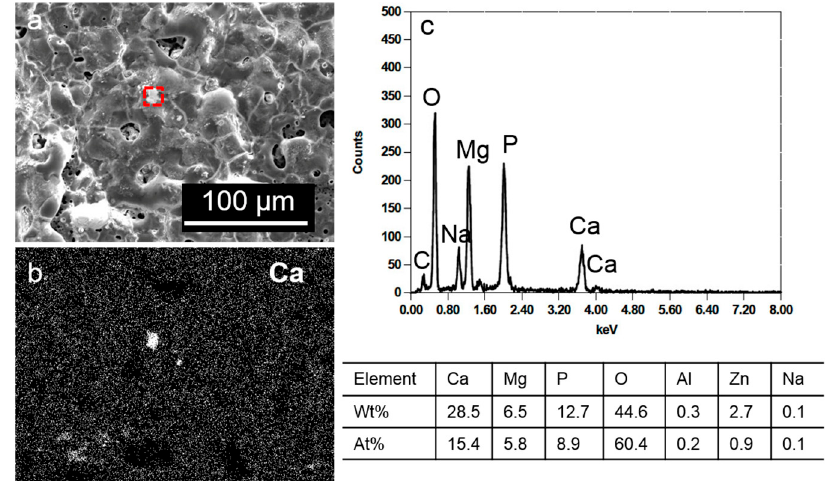
Figure 8. ( a ) SEM micrograph of the PEO film resulting from 10 min anodization of AM60-1Ca specimen in 0.5 mol dm − 3 Na 3 PO 4 solution at 25 °C; ( b ) the corresponding EDX maps for Ca; and ( c ) the spectra from red square area in image (a) and the elemental composition.